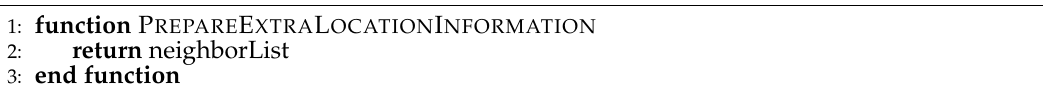
Algorithm 5 : at producer P , prepare extra location information (Assigned-brokers